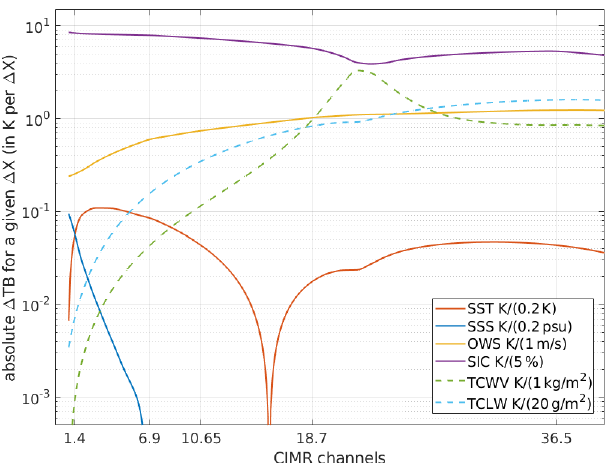
Figure 4. Changes in measured TB TOA corresponding to the re- quired precision of the CIMR parameters. The sensitivities are not normalized and presented with a logarithmic scale for the y axis. Calculations are performed as a function of frequency, at 55 ◦ incidence angle, in the Arctic (SST = 0 ◦ C, OWS = 6m/s, SSS = 34psu, TCWV = 5kg/m 2 ). The units are indicated in the legend for each